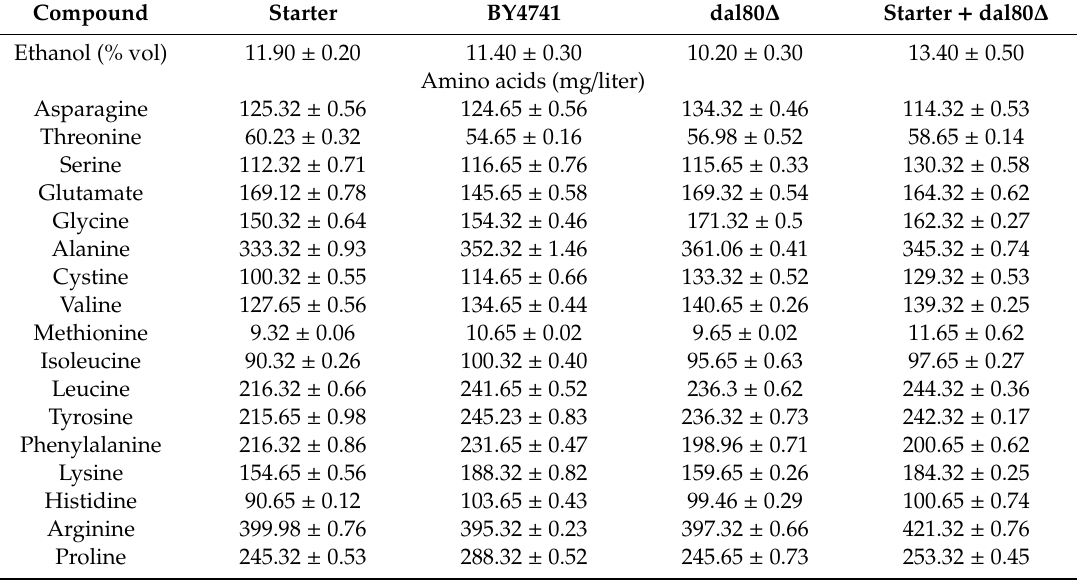
Table 1. Measurement of ethanol and amino acids in the fermentation of Chinese rice wine 1